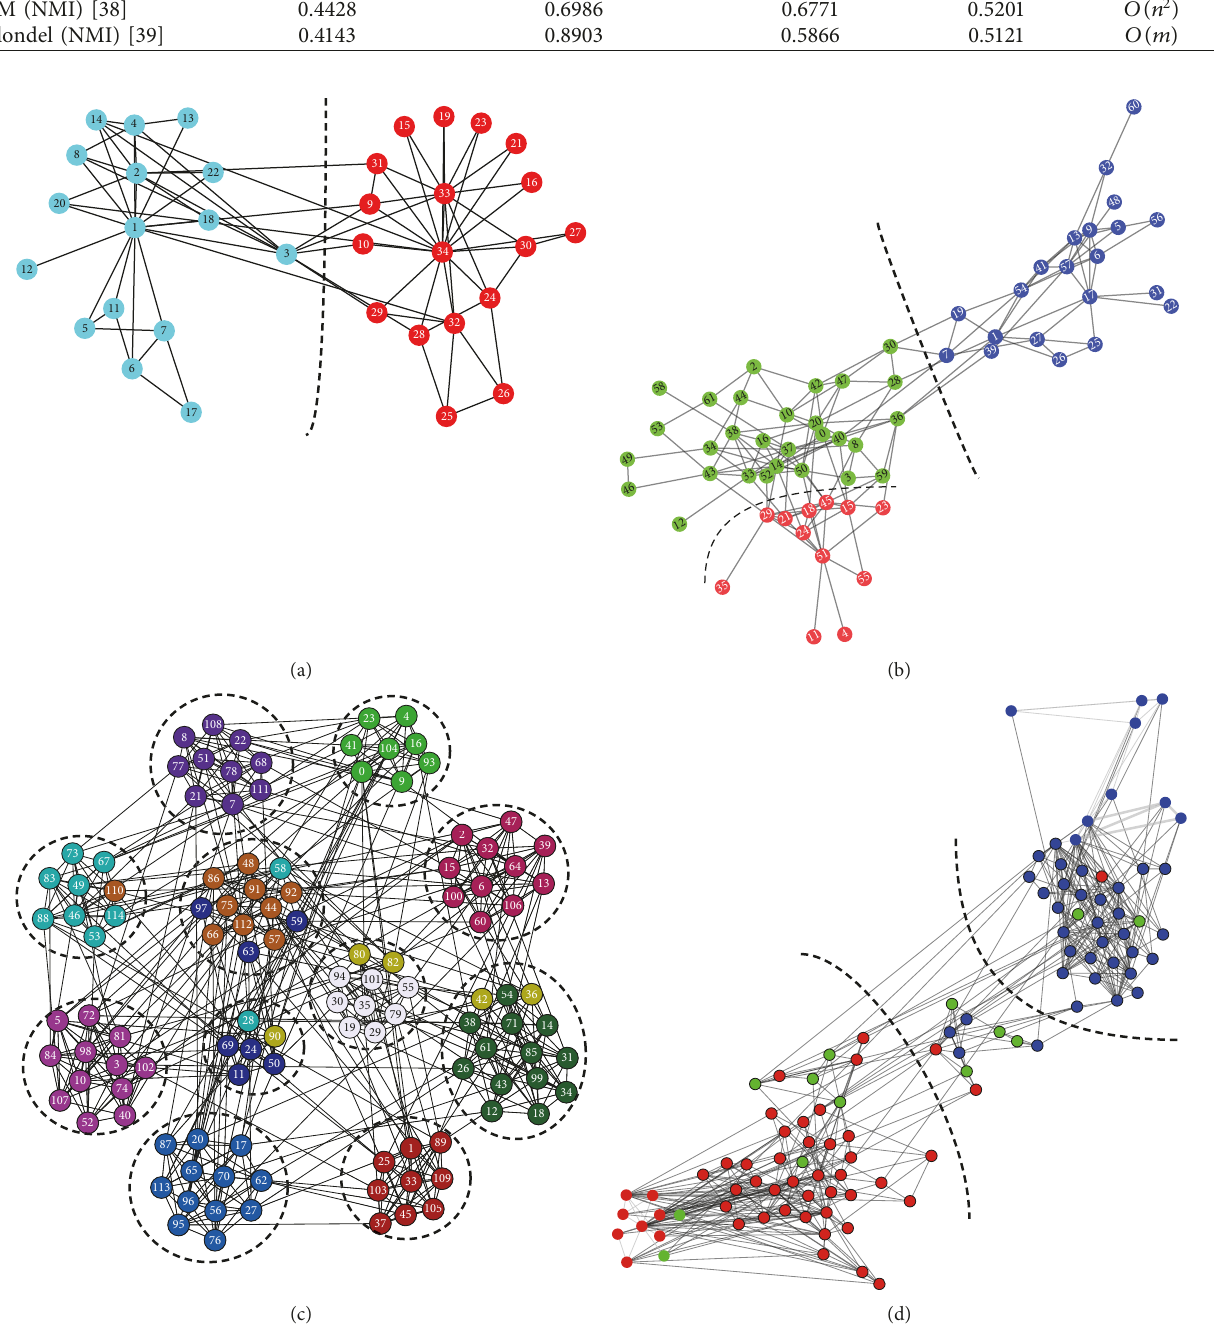
Figure 5: The detection results for various real-world networks. For the karate network (a), the result is identical with the original. But for the dolphin network (b), the left community in the original has been divided into two communities, which are marked in red and green, respectively. In the football team network (c) and the political books network (d), the detected communities are illustrated by dashed lines and the original partitions are distinguished by different colors. The parameters β � 3, c � 0 . 9, and ρ � 0 .